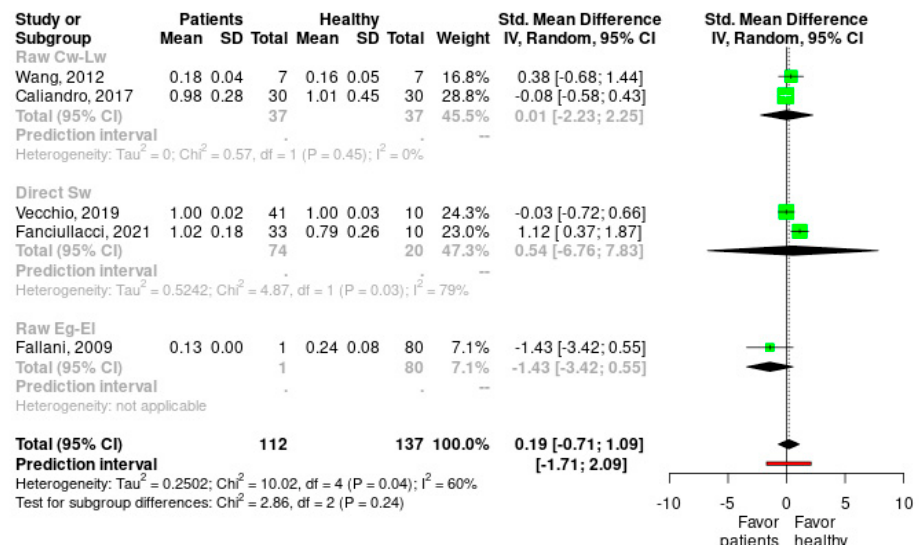
Figure 4. Subgroup forest plots for the different calculation methods of small-world index on healthy subjects vs. stroke patients. Cw: weighted clustering coefficient; Lw: weighted characteristic path length; Eg: global efficiency; El: local efficiency. SD: standard deviation; SMD: standardized mean difference; 95%CI: 95% confidence interval; Tau 2 : τ 2 between studies variance estimation; Chi 2 : Cochran Q test; df: degrees of freedom; I 2 : proportion of the variance in observed effect is due to variance in true effects rather than sampling error [7,8,10,12,13].